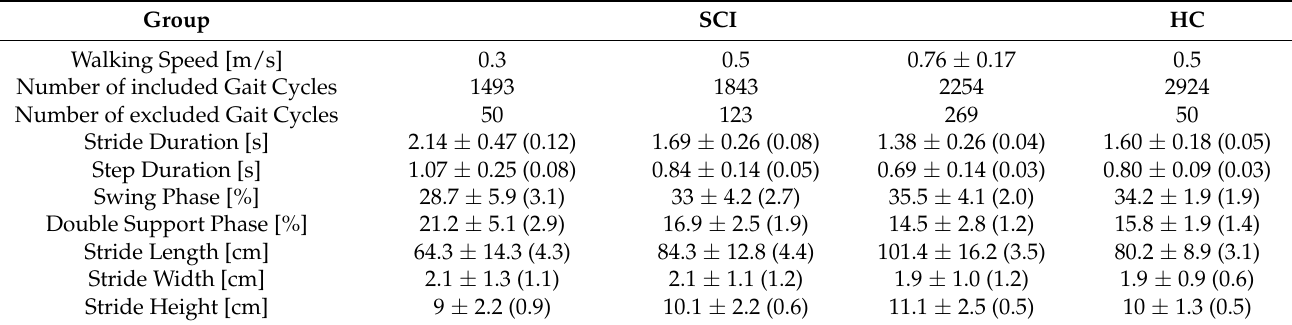
Table 2. Typical spatio-temporal parameters derived from the 3D motion capture and force plates are summarized for the SCI participants and healthy controls (HC). Values are given as mean ± standard deviation (intra-subject variability) for the different walking